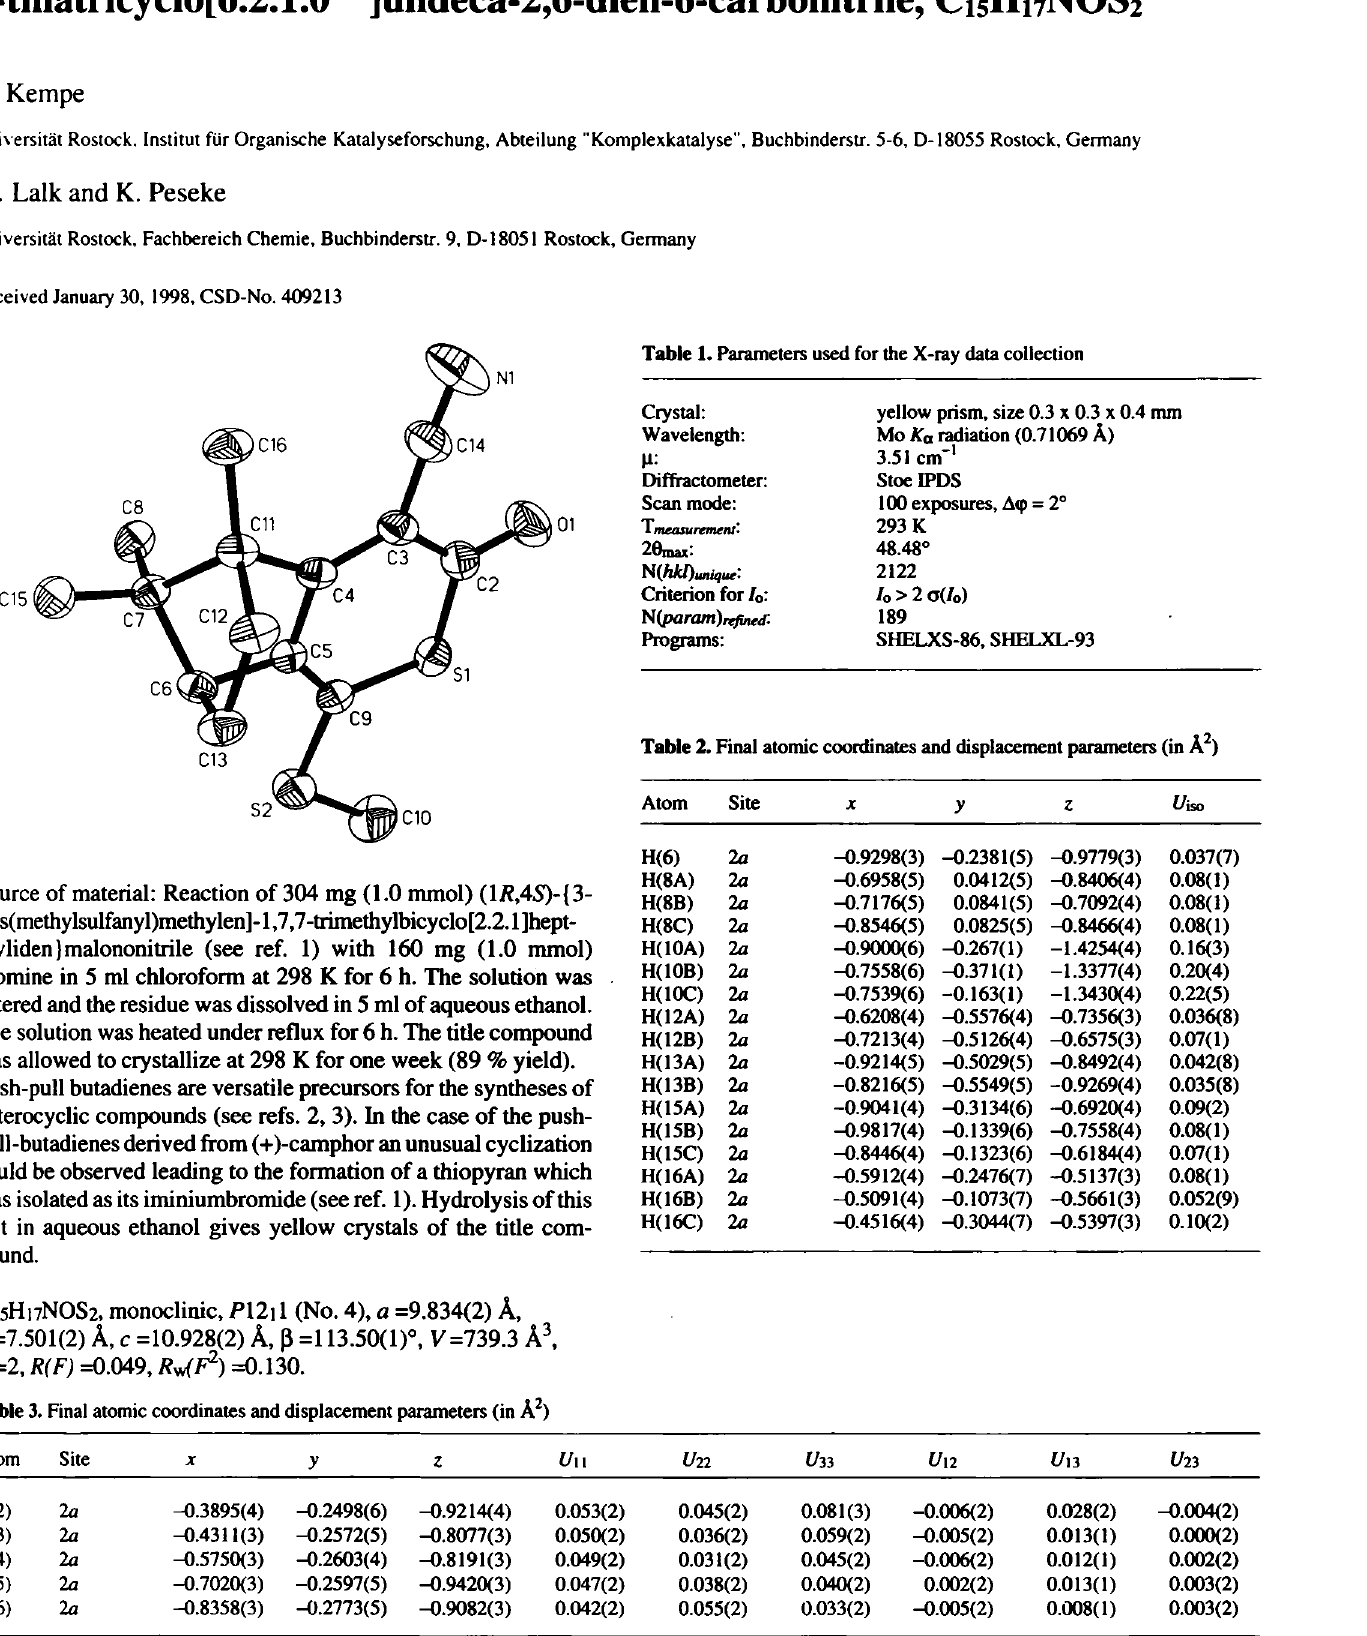
Table 1. Parameters used for the X-ray data collection Crystal: